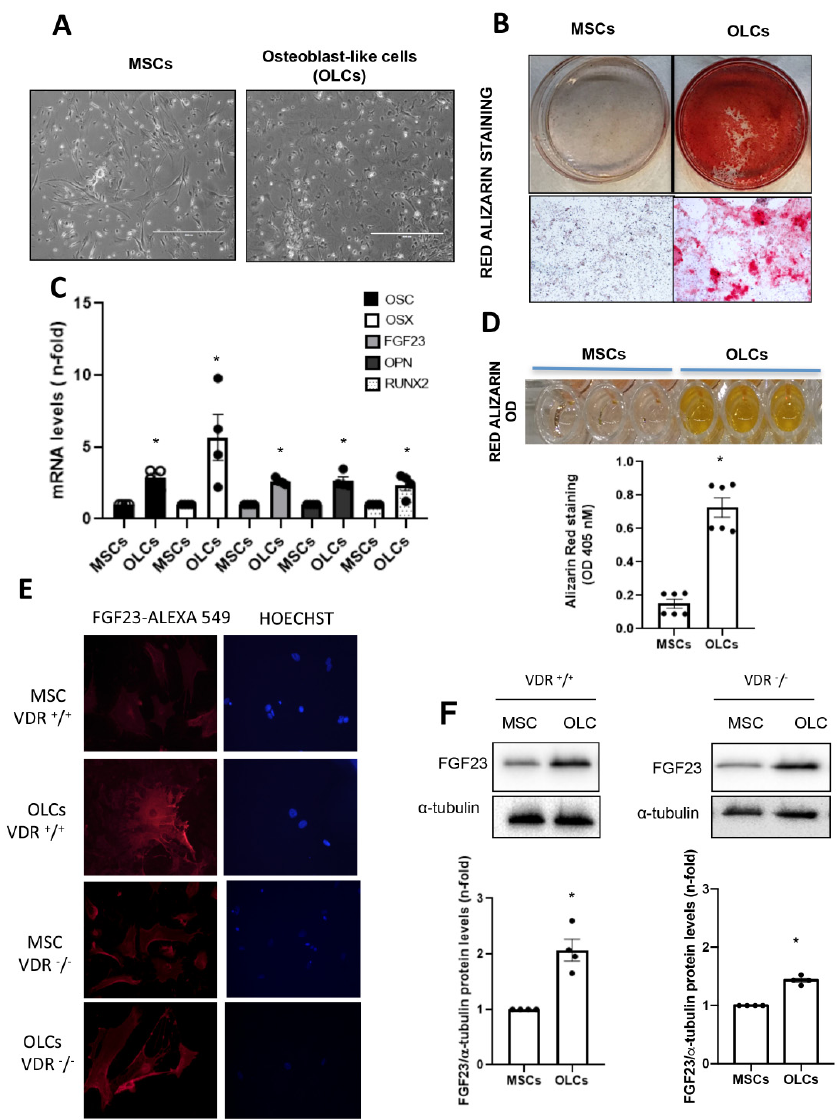
Figure 1. Establishment of an in vitro model to study FGF23 expression. Primary culture of mesenchy- mal stem cells (MSCs) from bone marrow of VDR +/+ and VDR − / − mice and MSCs differentiated to OLCs by culture for 21 days in an osteogenic differentiation medium. ( A ) Phenotypic differences between MSCs and OLCs by bright field microscopy. ( B ) Red alizarin staining to identify the min- eral matrix accumulation. ( C ) Gene expression of osteogenic and mesenchymal marker genes by RT-PCR. ( D ) Quantification of red alizarin staining by optical density. ( E , F ) FGF23 production by mature osteoblasts assessed by immunofluorescence ( E ) and Western blot ( F ). * p < 0.05 vs. OLC without